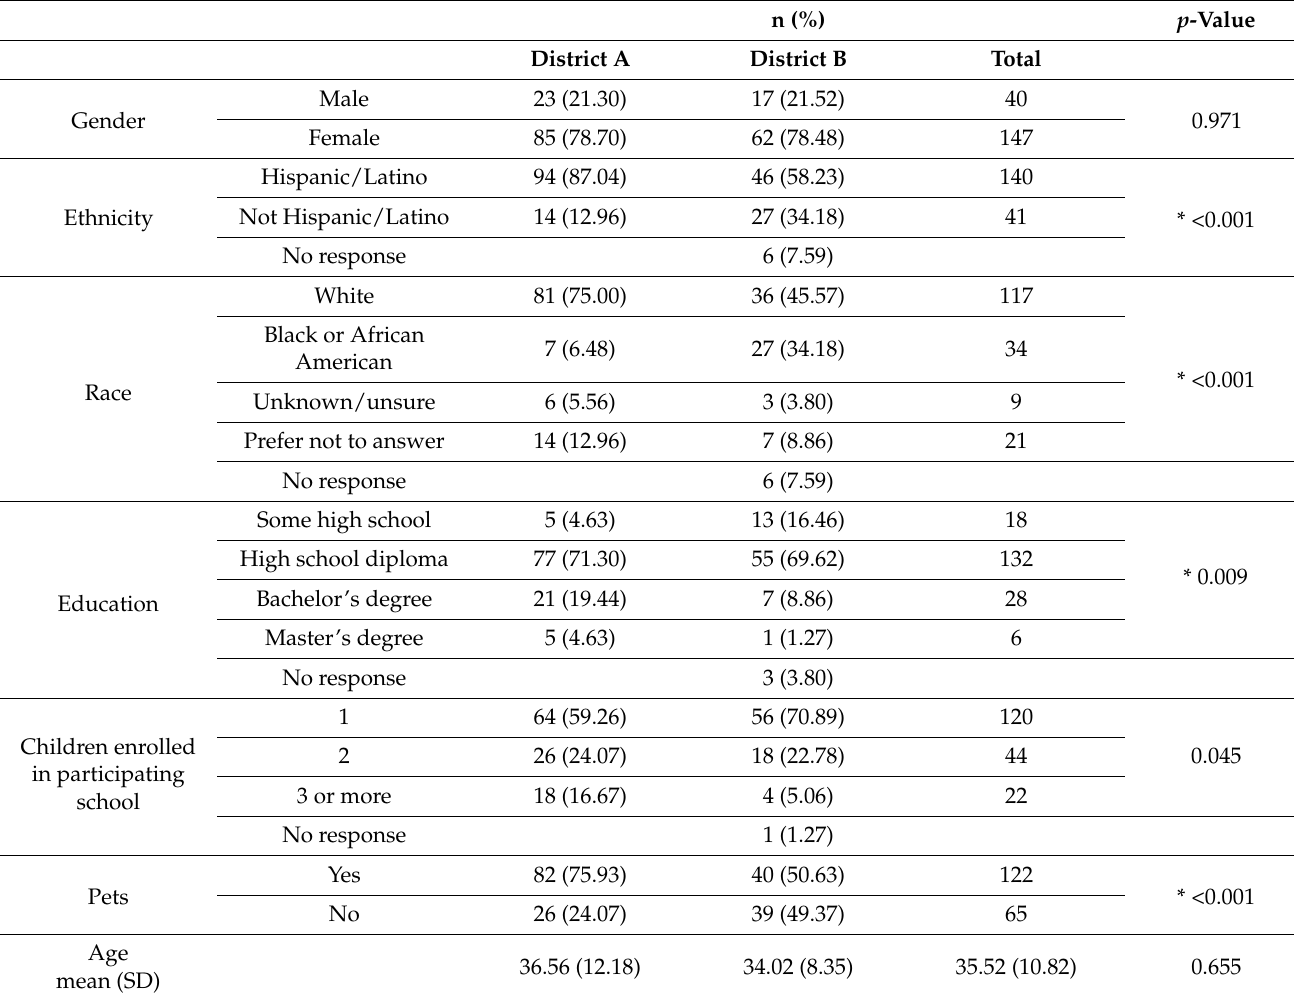
Table 1. Summary of the participant demographics—overall and by school